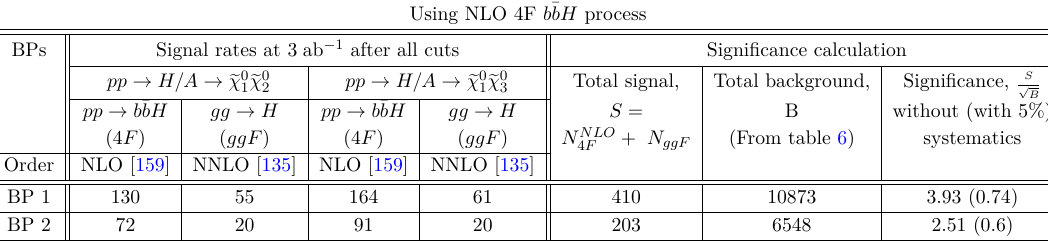
Table 8. The signal yield along with signal significance for the b-veto category of ‘‘ + /E state for NLO 4 F b ¯ bH process. N ggF , N NLO 4 F b ¯ bH production processes respectively.